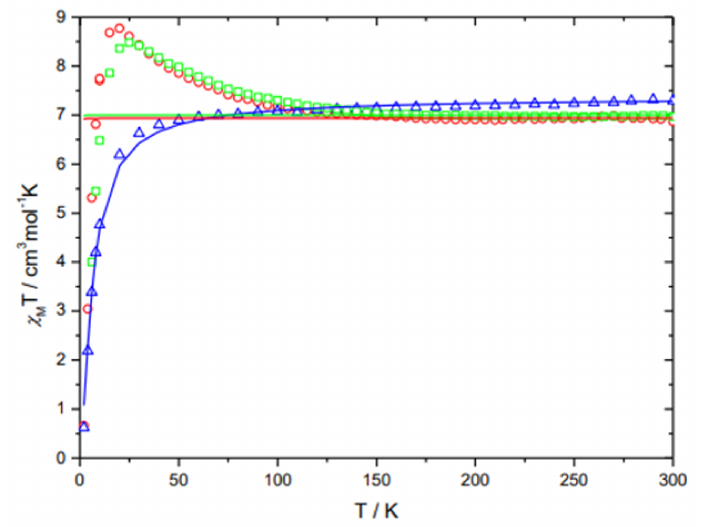
Figure 5. Temperature-dependent behavior of 1 (red open circles), 2 (blue open triangles) and 3 (green open squares) in form of the combined χ M T vs. T